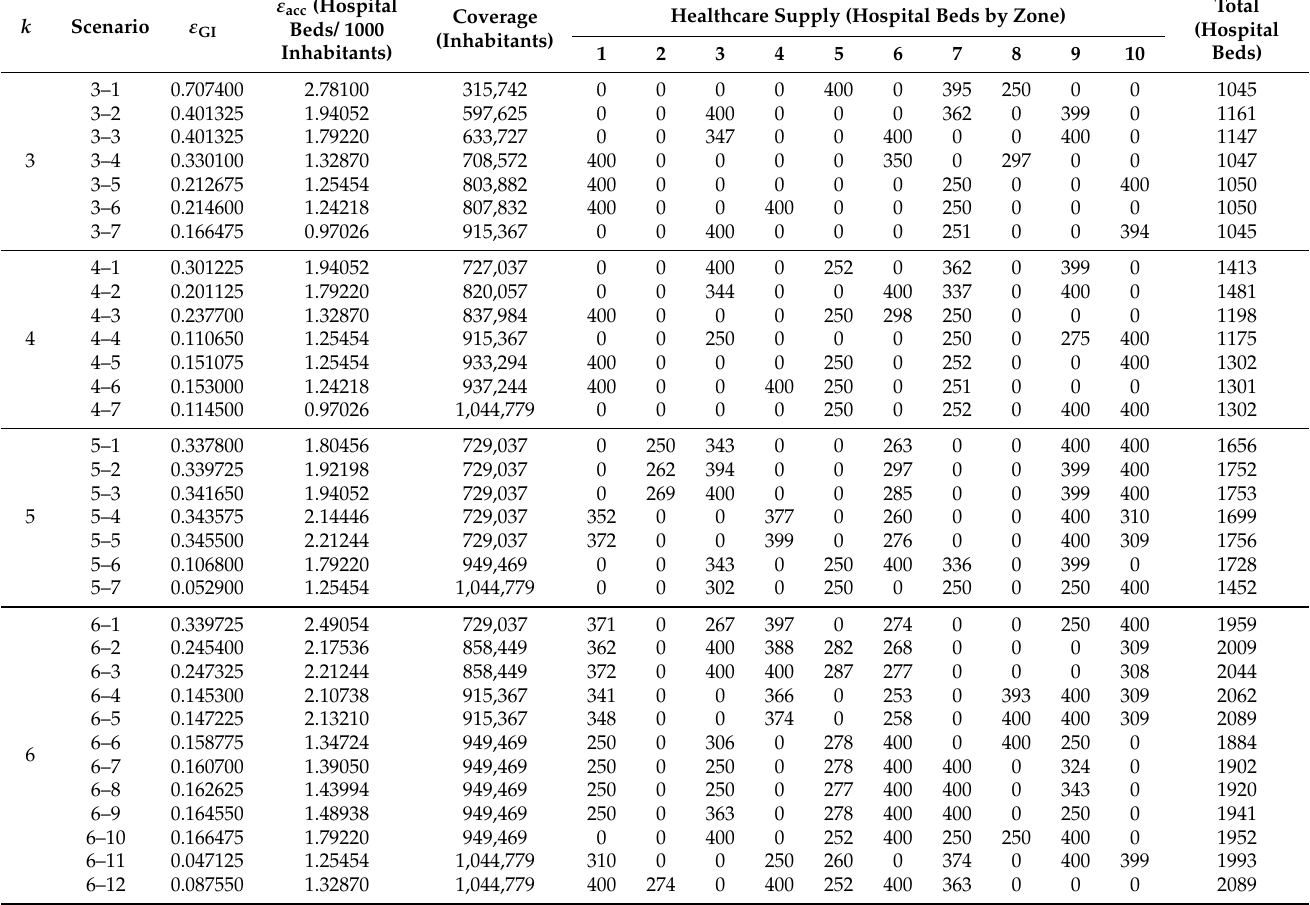
Table 2. Pareto frontier set for the listed k , scenario, zone, and other indicators in instance